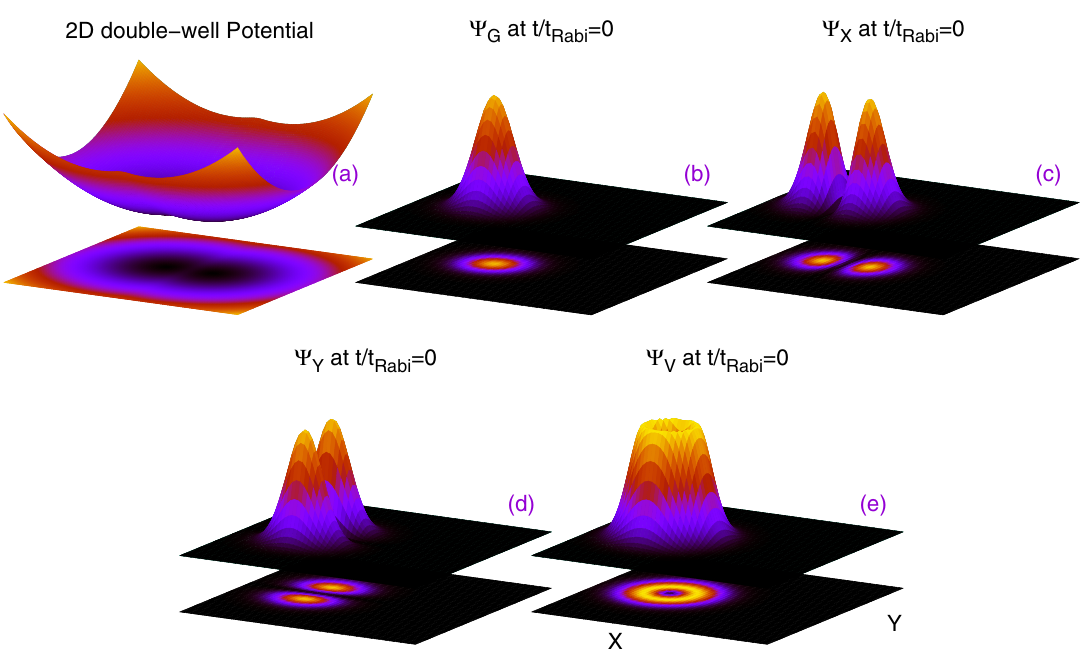
Figure 1. Schematic diagrams for ( a ) the 2D double-well potential described in Eq. (3) and the initial density distributions for ( b ) (cid:31) G , ( c ) (cid:31) X , ( d ) (cid:31) Y , and ( e ) (cid:31) V . The x - and y -axes are shown in panel ( e ). The quantities shown are